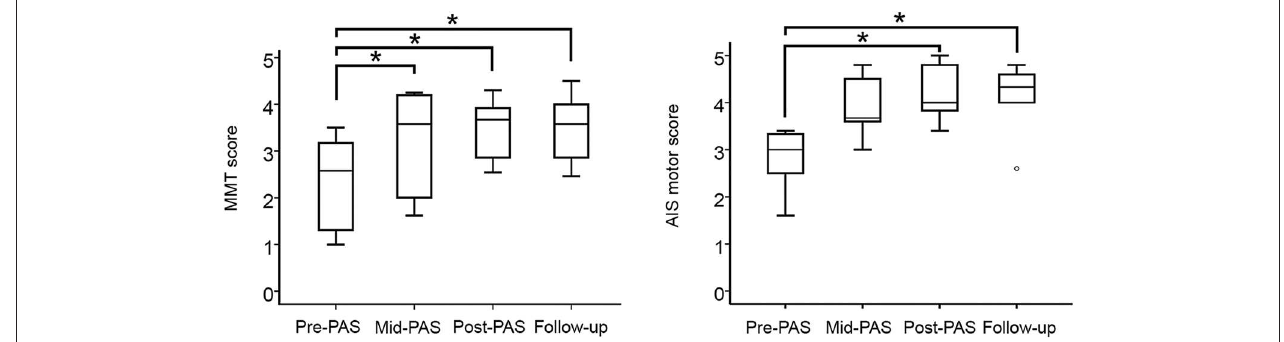
FIGURE 2 | Medians of MMT scores (left) and AIS motor scores (right) before the intervention (Pre-PAS), after 1 month (Mid-PAS), and after 2 months (Post-PAS) of stimulations and in the 1-month follow-up. Asterisks show significant differences ( n = 5, p <